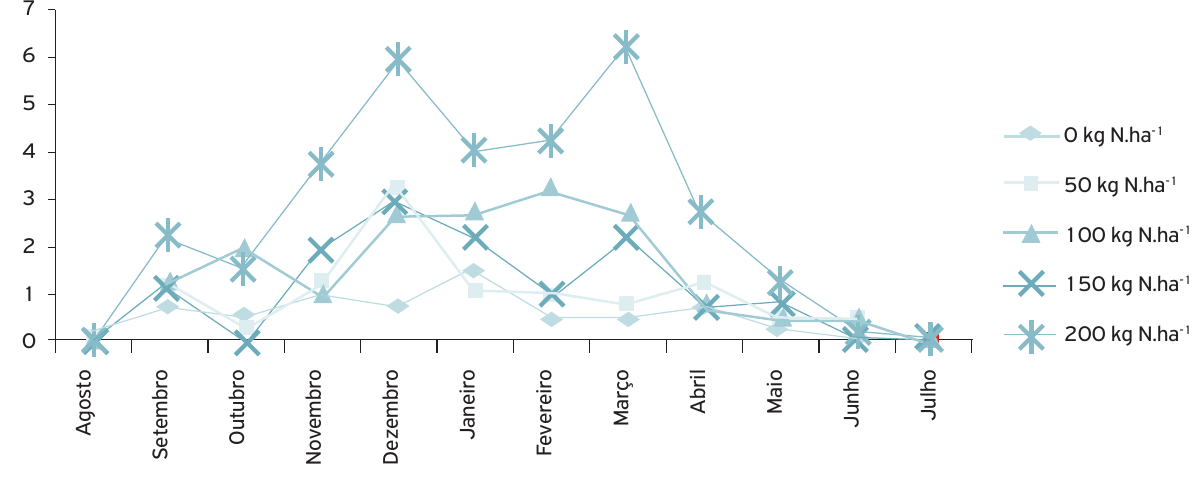
Figura 2. Número médio de ninfas de M. fimbriolata em razão da aplicação de diferentes doses de N-fertilizante, entre os meses de agosto de 2010 e julho de 2011, safra 2010/2011, em cana-de-açúcar